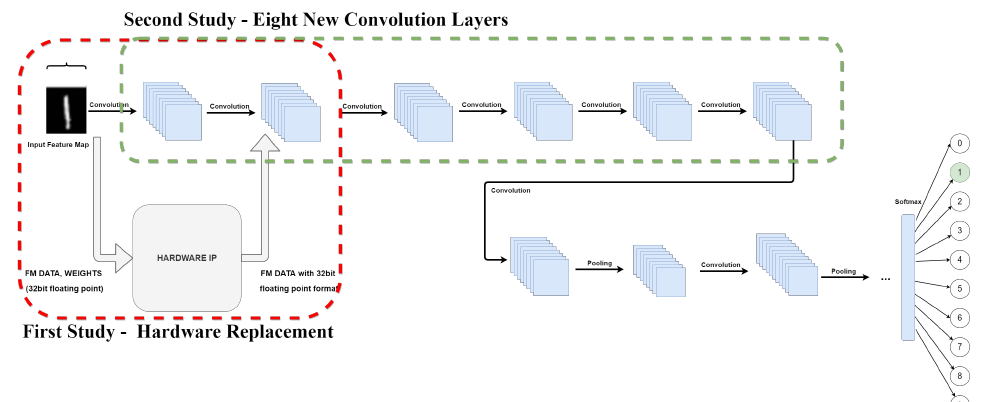
Figure 11. Two quantization studies on the MNIST model. Hardware replacement and influence on model performance as a function of model depth.